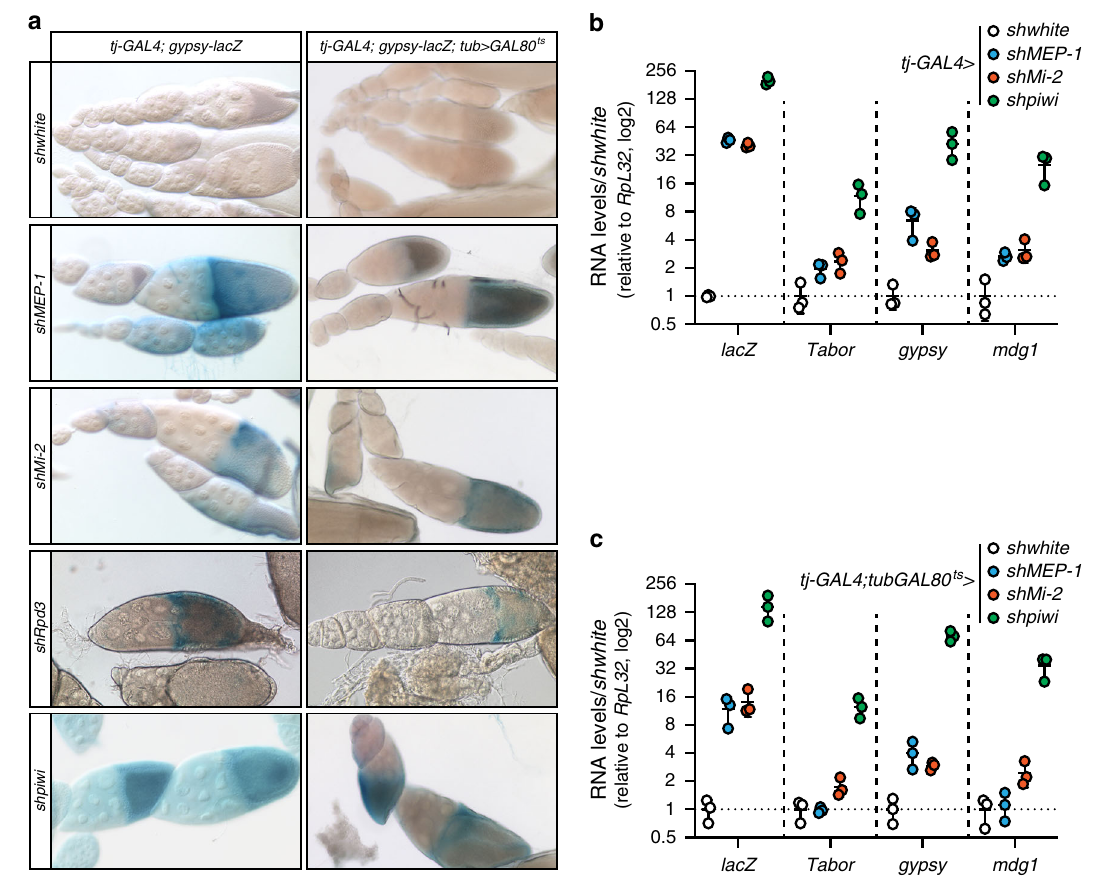
Fig. 4 The ovarian somatic depletion of MEP-1 or Mi-2 results in TE and TE reporter derepression in vivo. a X-Gal staining of egg chambers that contain the somatic TE reporter ( Gypsy-lacZ ) in which the indicated genes were knocked down by constitutive (left panel) or conditional (right panel) somatic RNAi. Conditional somatic knockdown was restricted to adult fl ies. The control was a shRNA against the white gene ( shwhite ). b , c Fold change (log2) in the steady-state RNA levels of the Gypsy-lacZ reporter (lacZ) and of three endogenous TEs in ovaries after constitutive ( tj-GAL4 > sh ) ( b ) or conditional ( t- jGAL4 ; tubGAL80 ts > sh ) ( c ) somatic knockdown, using the indicated RNAi. RNA levels were quanti fi ed relative to RpL32 levels and normalized to control knockdown ( shwhite ). Lines represent means ± SD for n = 3 biologically independent samples. Source data for b , c : Supplementary Data set